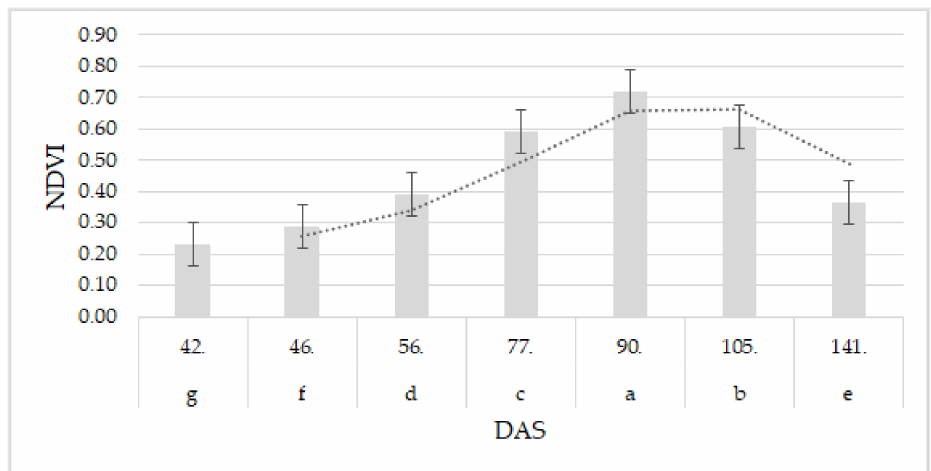
Figure 4. The NDVI UAV values of maize as the effect of days after sowing (DAS) (Debrecen, 2021); means of the varieties ± standard error. The differences among the measurement days were significant at the p = 0.001 level. Different letters mean significant difference at the p < 0.05 level among the measurement days. LSD = 0.003.